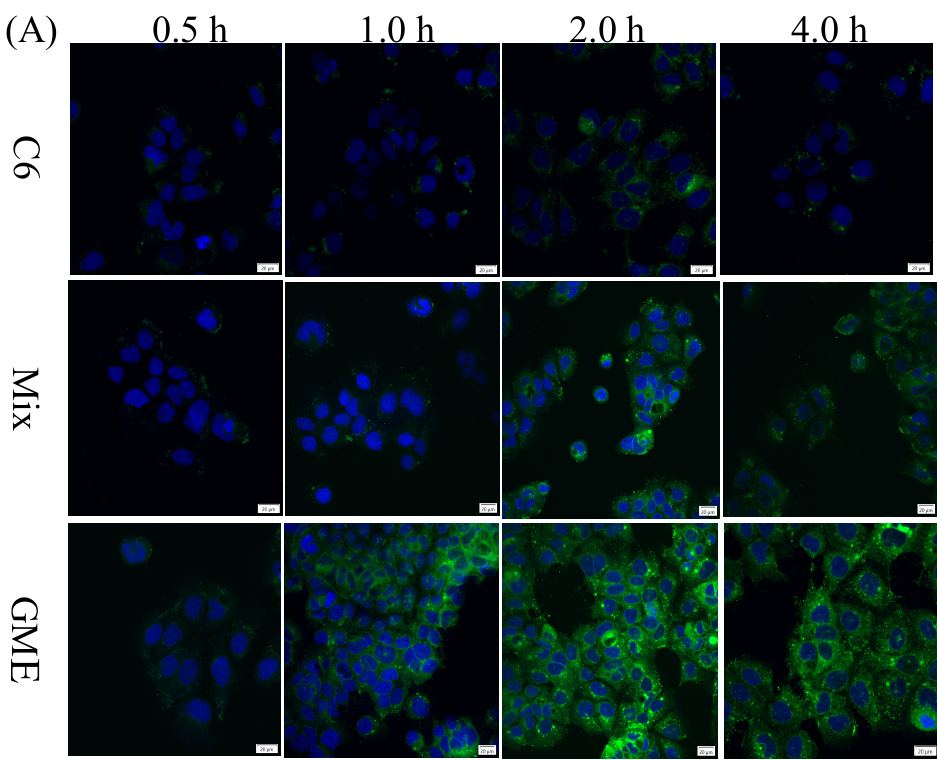
Figure 5. Cytotoxicity of empty microemulsion, free genipin, and GME on Caco-2 cells. Empty microemulsion ( A ); free genipin and GME ( B ). Error bars are SD ( n = 6); ** p ≤ 0.01; ## p ≤ 0.01. Compared with the group treated with the same concentration of free genipin.